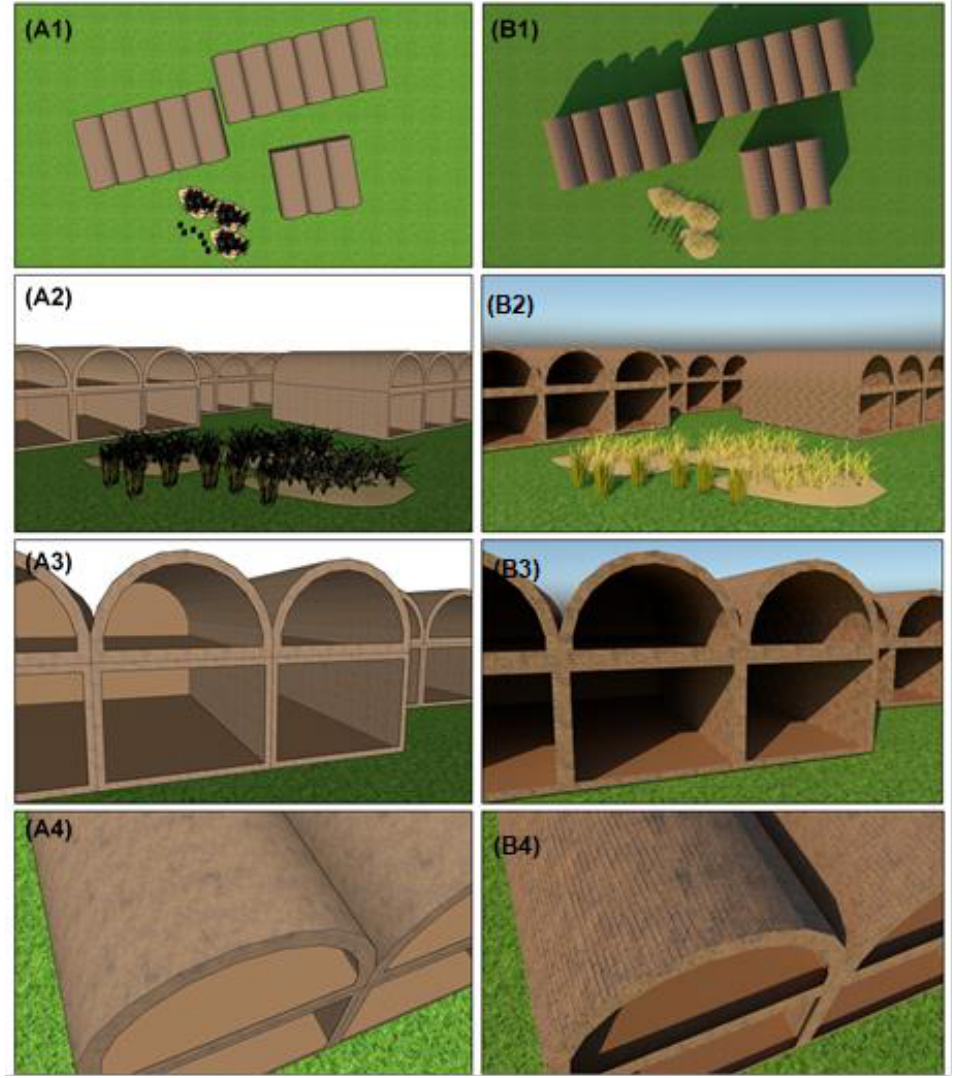
Figure 13. Constructed 3D model of the remotely sensed Installations A–C. ( A1 – A4 ) show varying angles of the structures generated via SketchUp Pro. ( B1 – B4 ) show the final product with rendered materials and textures via the Chaos V-Ray